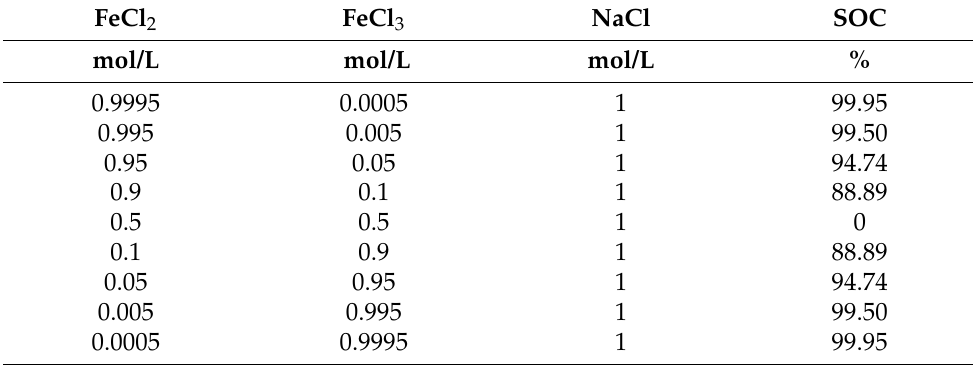
Table 1. Overview of the used concentrations and their respective states of charge